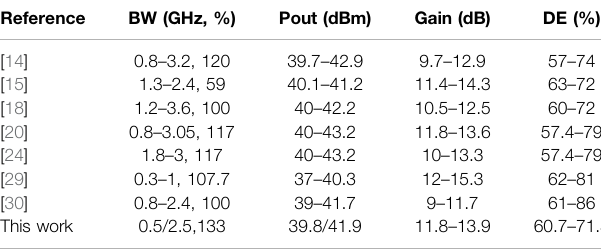
TABLE 1 | Comparison with recently reported broadband